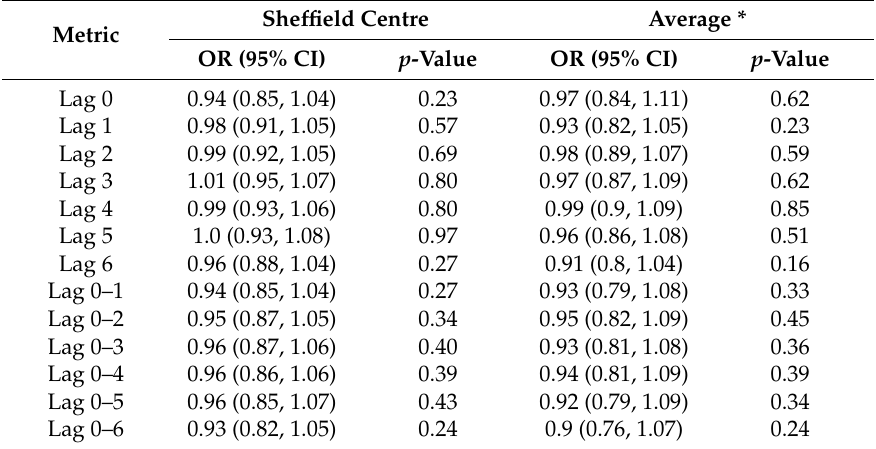
Table 2. Association between NO and RSV admissions using data from a central monitoring station vs . average NO concentration from three monitoring stations.